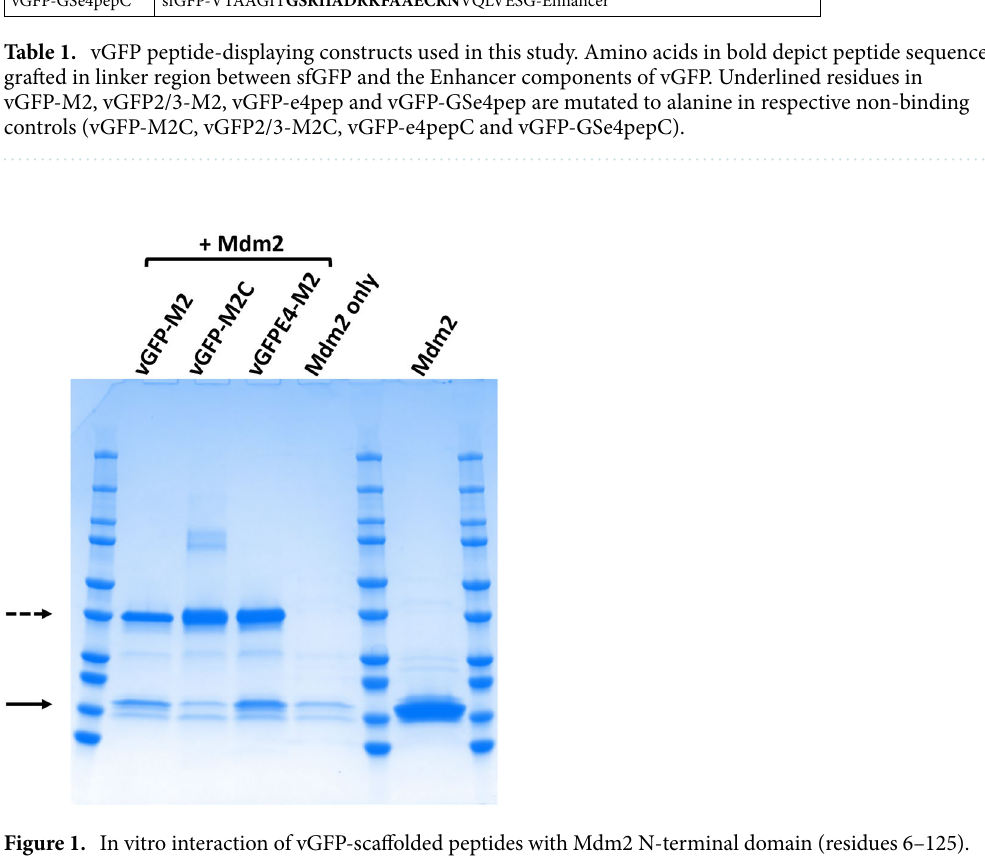
Figure 1. In vitro interaction of vGFP-scaffolded peptides with Mdm2 N-terminal domain (residues 6–125). Indicated purified proteins were (co)-incubated and the pulled down complexes analysed by SDS PAGE. Upper and lower arrows correspond to engineered vGFP proteins and interacting Mdm2, respectively. Experimental repeat is shown in Supplementary Fig.